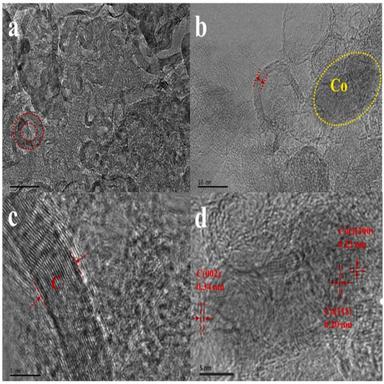
TEM images of the Co-SPCP, the hollow spherical structure of the Co-SPCP(a), the existence of Co nanoparticles(b), the existence of graphitized carbon shells(c) and the lattice fringes of element Co and graphitized carbon(d).